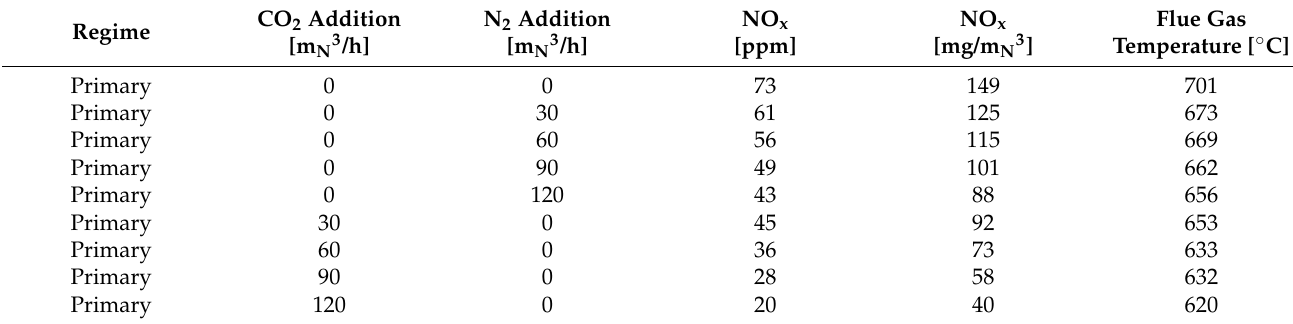
Table 7. Experimental matrix—TEST A—Burner